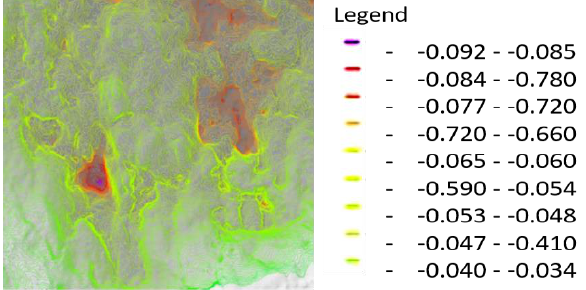
Figure 21. DTM of the wall sample – visualized in contour